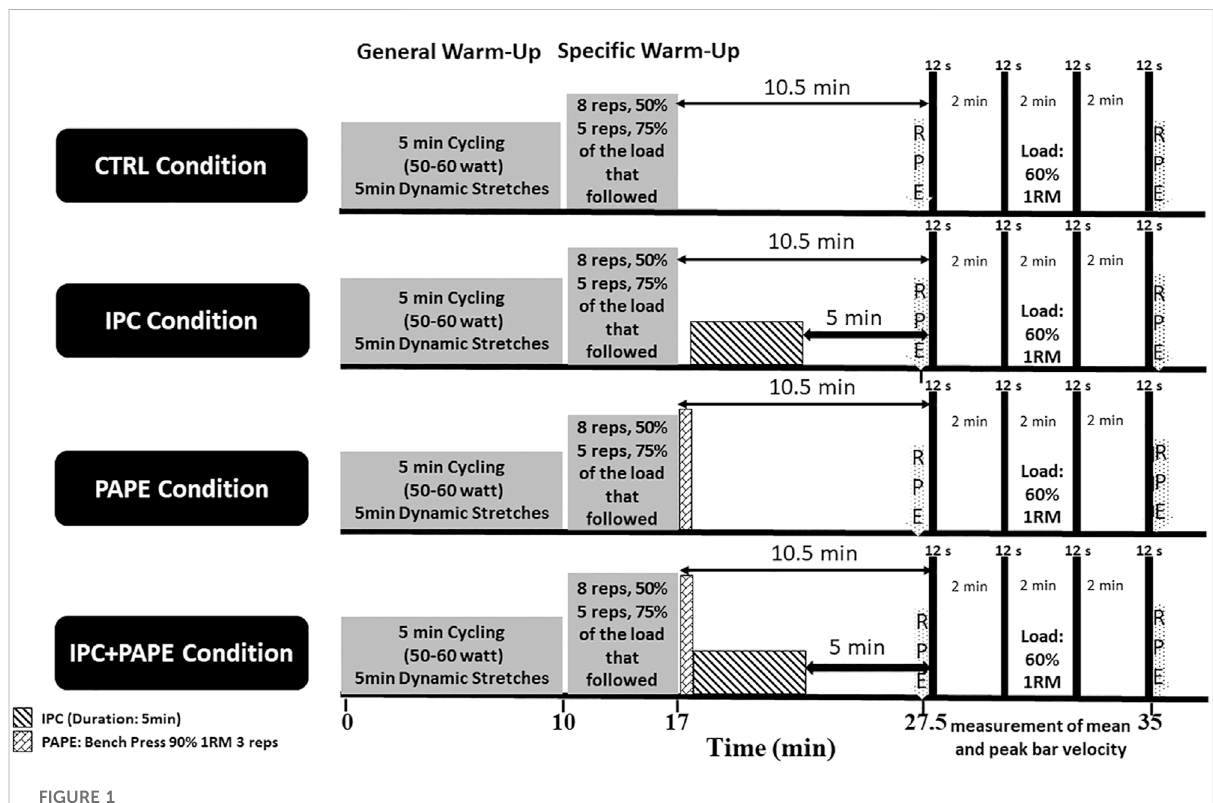
FIGURE 1 Schematic representation of the experimental